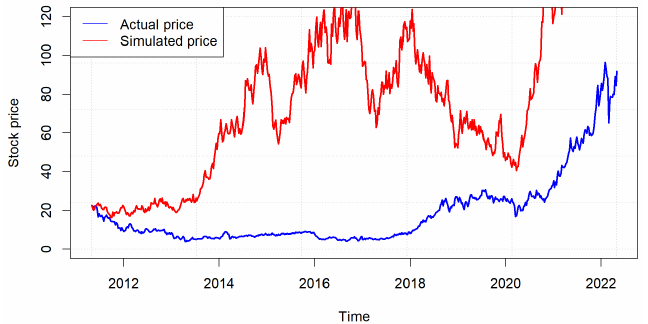
Figure 15. GBM Simulation